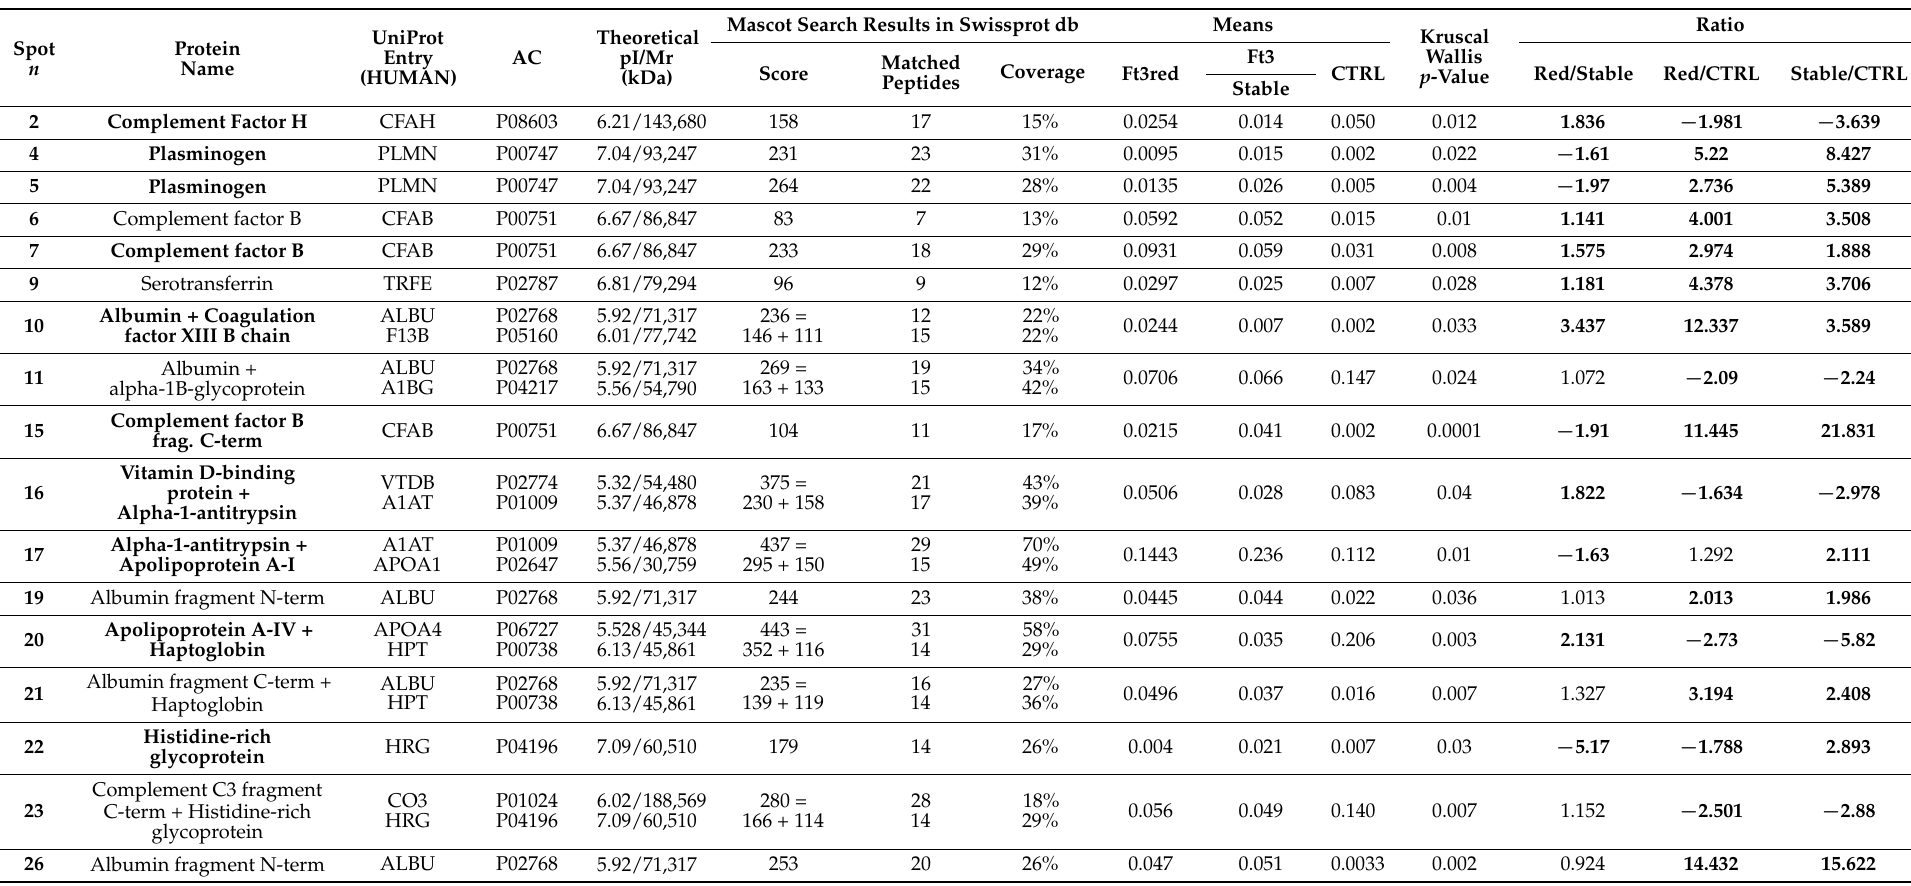
Table 3. The table reports UniProtKB protein description, abbreviation, accession number (AC), theoretical isoelectric point (pI), and molecular weight (MW). Spot numbers correspond to those in Figure 1. Mascot search results were reported by score, number of matched peptides, and sequence coverage. Moreover, the table reports the %V means, Kruskal–Wallis p -values and %V mean protein ratio in stable FT3, reduced (Red) FT3, and controls (CTRL). Numbers in bold in “Ratio” column highlight the valid fold change ≥